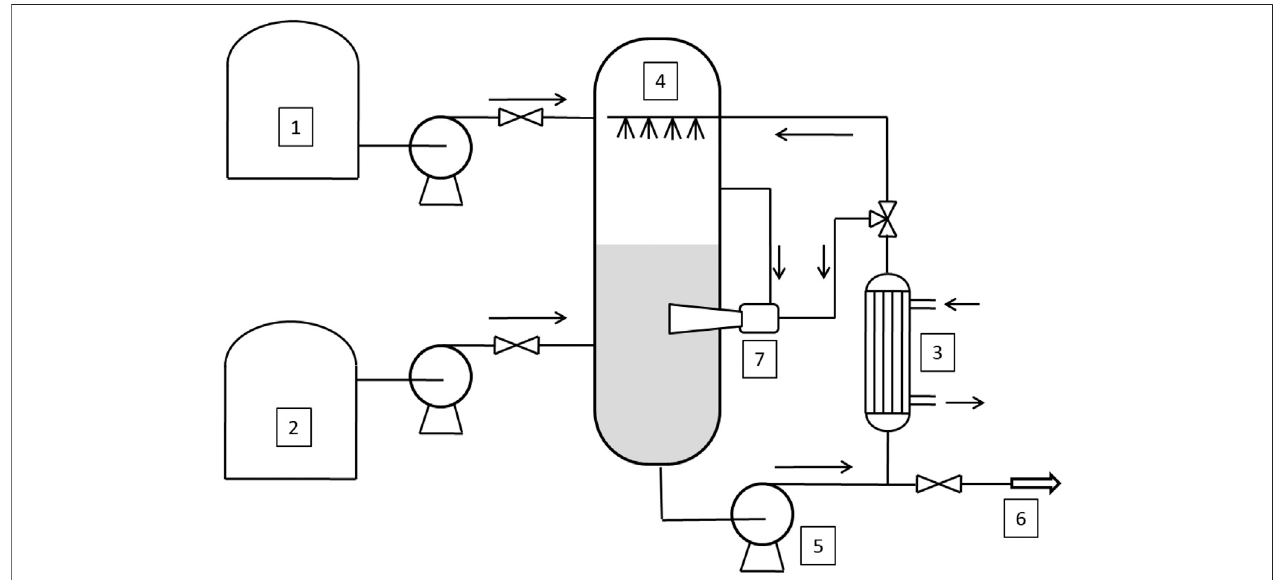
FIGURE 3 | Sketch of the Enhanced Loop Reactor (ELR). 1 – 2: tanks, 3: heat exchanger; 4: spray nozzles; 5: recirculating pump; 6: outlet stream; 7: